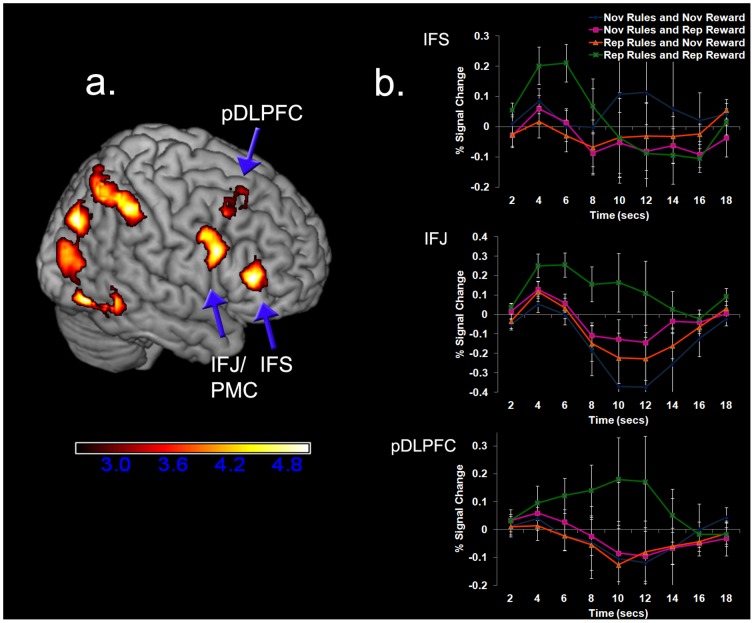
Regions Showing Repetition Enhancement for Repetition of a Specific Rule-Outcome Pairing (Z>2.57, p<.05 FWE cluster corrected for the whole-brain).
A. Right lateral view showing regions of the LPFC exhibiting this effect. B. Activation time-course for the IFS, IFJ, and posterior DLPFC time-locked to the onset of the second instruction. The color scale denotes t-values. Nov = novel, rep = repeated. Error bars represent one (within-subject) standard error of the mean based on Loftus and Masson [69].